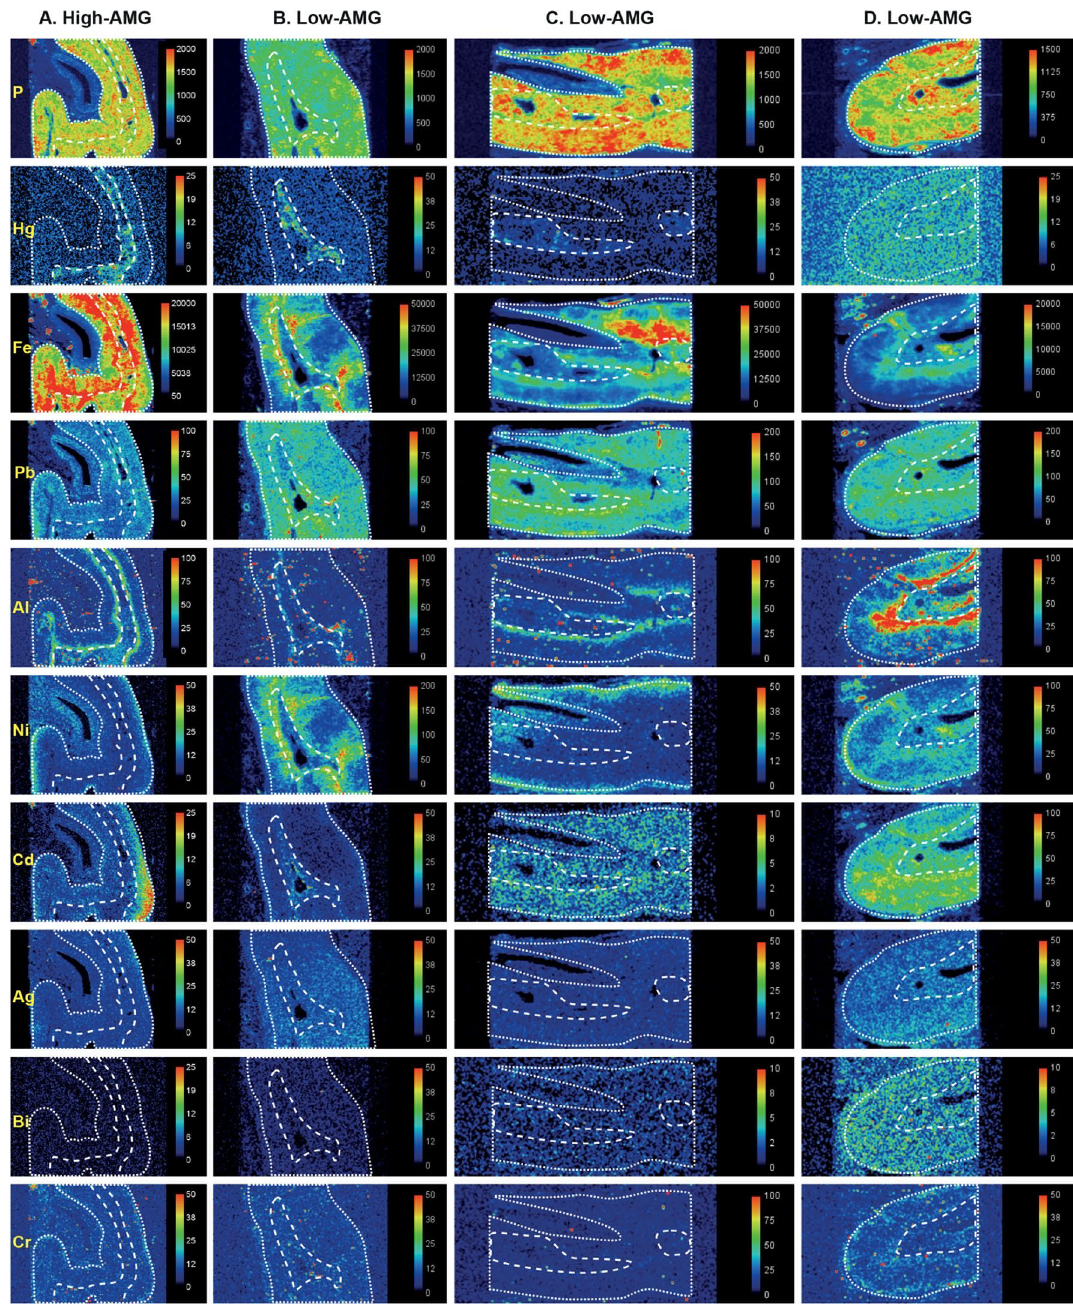
Figure 7. LA-ICP-MS II. The dotted lines outline the adrenal gland in the section, the medulla is outlined by the internal dashed lines, and the cortex occupies the space between the dashed and dotted lines. Phosphorus LA-ICP-MS indicates the degree of cellularity. Mercury is present selectively in the medulla of one high-AMG sample ( A ). In the three low-AMG samples, mercury is present in the medulla in two ( B , C ), but not detected in one ( D ). Metals present in both cortex and medulla are lead ( B – D ), nickel ( B , D ), cadmium ( C , D ), mercury ( D ), iron ( A ), and bismuth ( D ). Cadmium is present selectively in one medulla ( B ). Metals mostly in the cortex are iron ( B – D ), aluminium (in the zona reticularis, A , D ), cadmium ( A ) and silver ( D ). Scale = counts per second (proportional to